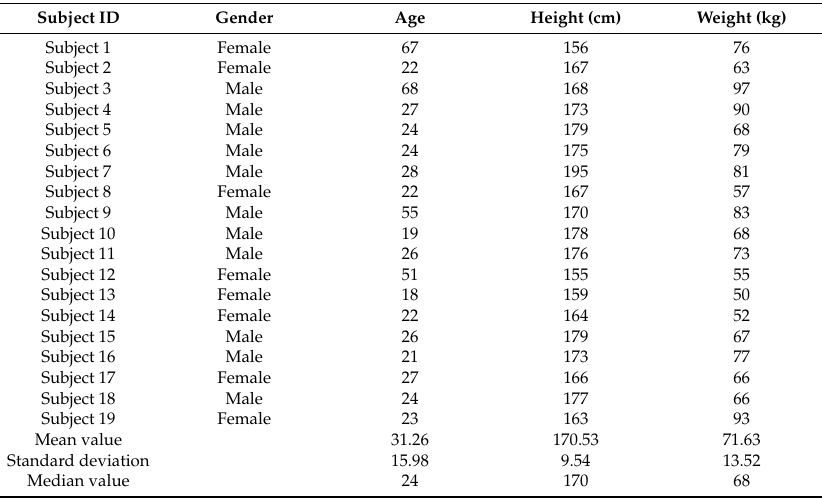
Table 1. Personal characteristics of the participants in the